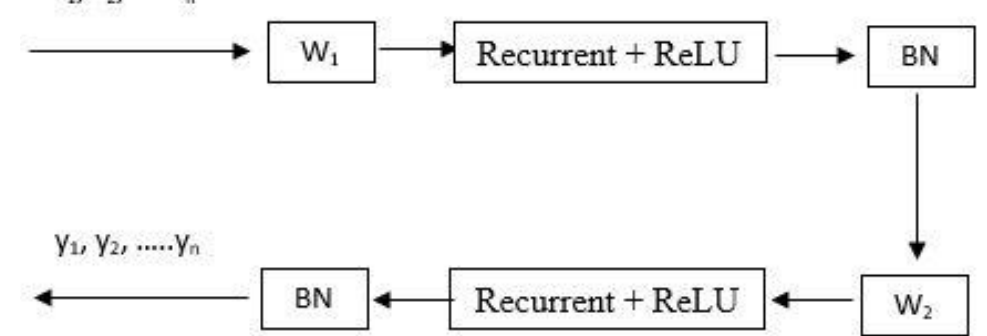
Figure 2. Independently Recurrent Neural Network (IndRNN) frame structure.